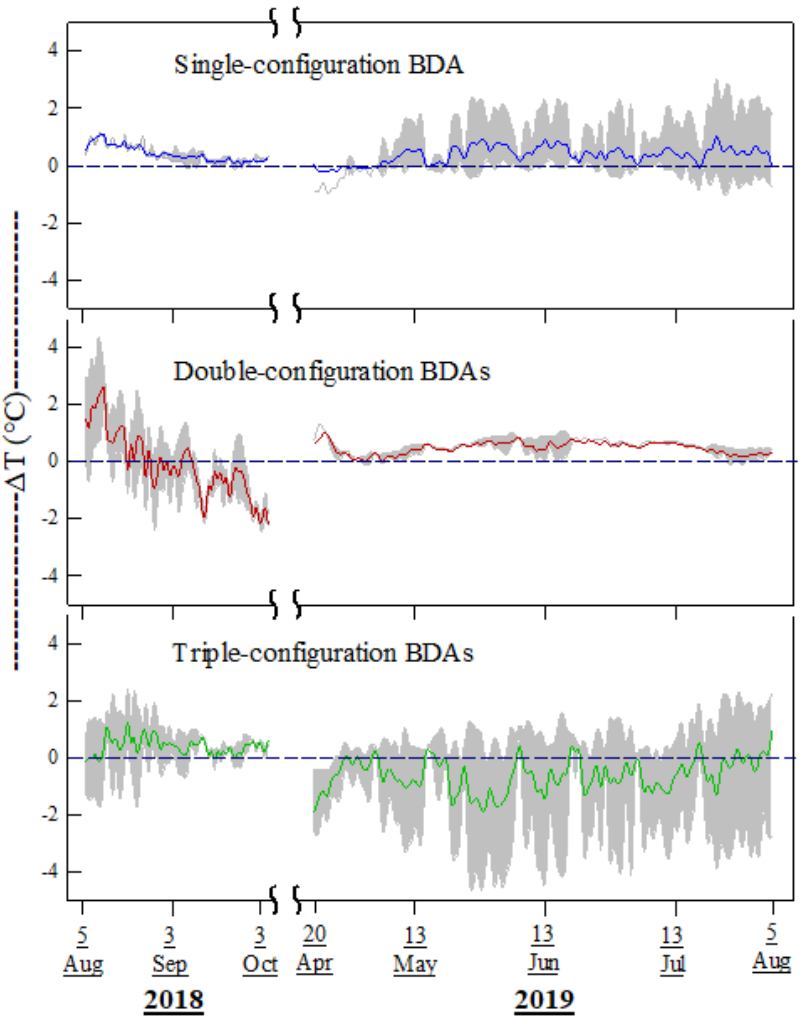
Figure 4. Difference in temperature (ΔT; downstream—upstream) for different BDA configurations used over the 2018–2019 post-BDA installation period (2018–2019).